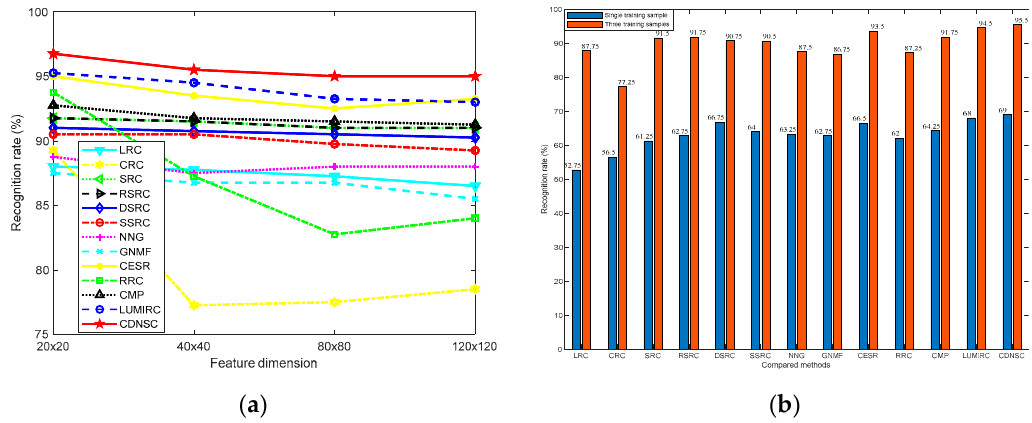
Figure 6. Recognition rate versus the dimension and number of training samples in the CASIA database. ( a ) Sample dimension, ( b ) Sample number.